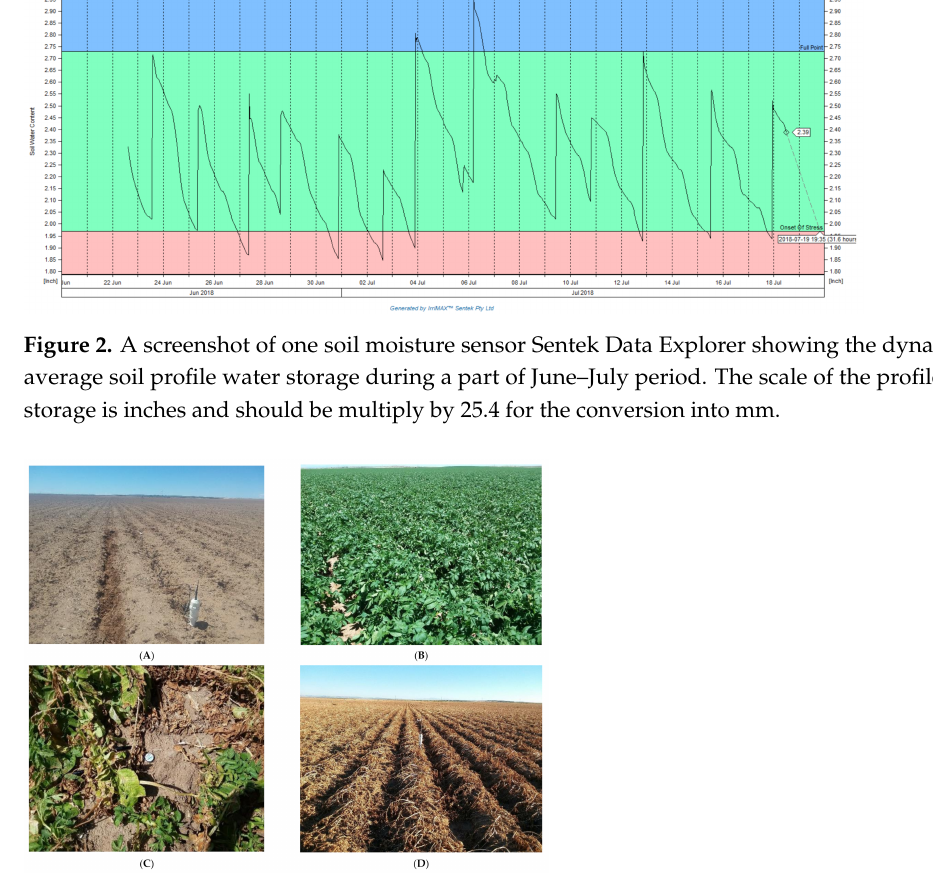
Figure 3. Soil moisture sensor Sentek installed just after potato planting ( A ), potato crop aspect at vegetative phase ( B ), at crop maturity showing the sensor ( C ) and field aspect just before harvest ( D